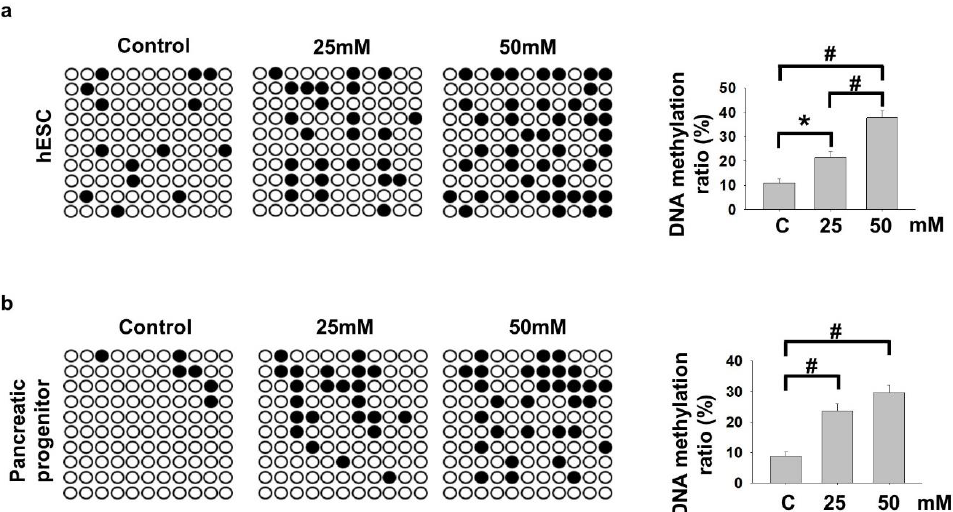
Figure 3. Hyperglycemia led to persistent hypermethylation of NKX6 − 2 promoter. ( a ) Bisulfite sequencing results showing the DNA methylation status of NKX6 − 2 promoter in undifferentiated VAL3 under different conditions. Black and white dots represented methylated and unmethylated CpG sites, respectively ( n = 30, * p < 0.05, # p < 0.001, Chi-square test). ( b ) Bisulfite sequencing results showing the DNA methylation status of NKX6 − 2 promoter in PP cells differentiated from VAL3 cultured in different conditions ( n = 30, # p < 0.001, Chi-square test).